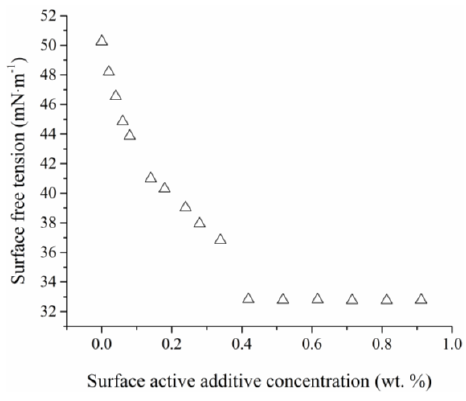
Figure 3. Surface tension of Co-PES dispersion vs. surface active additive (Agent 1) concentration.